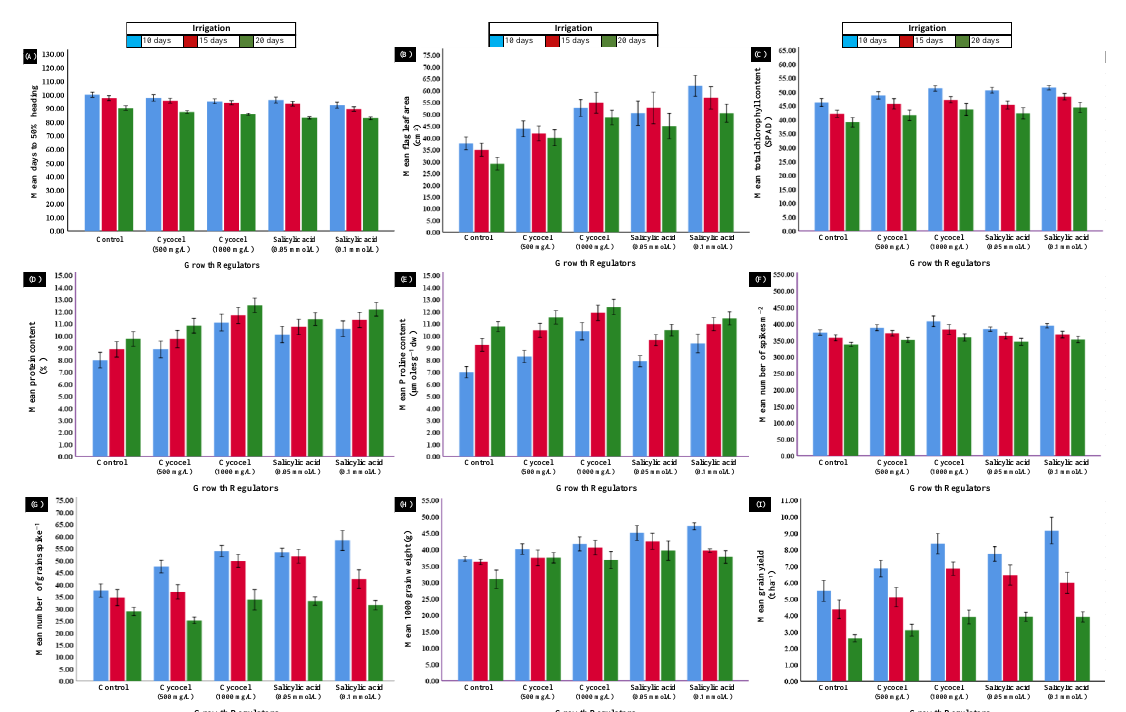
Figure 1. Error bar chart showing the effect of the interaction between irrigation and growth regulators of ( a ) mean days to 50% heading, ( b ) mean flag leaf area (cm 2 ), ( c ) mean total chlorophyll content (SPAD), ( d ) mean protein content (%), ( e ) mean proline content (µmoles g −1 dw), ( f ) mean number of spikes m −2 , ( g ) number on grains spike −1 , ( h ) mean 1000 grain weight (g), ( i ) mean grain yield (t ha −1 ).